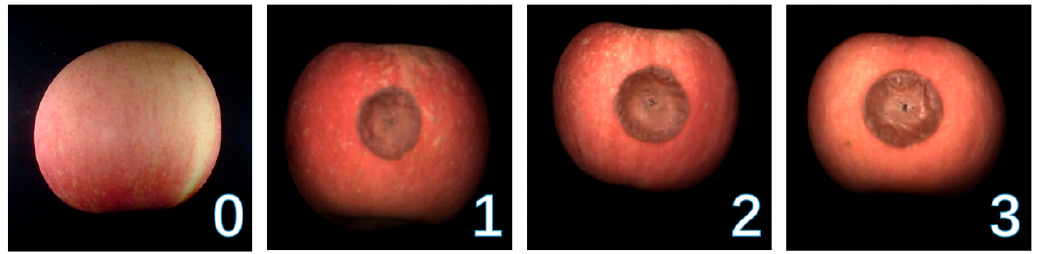
Figure 2. Images of apples with different degrees of infection. 0: healthy, 1: mildly infected, 2: moderately infected, 3: severely infected.